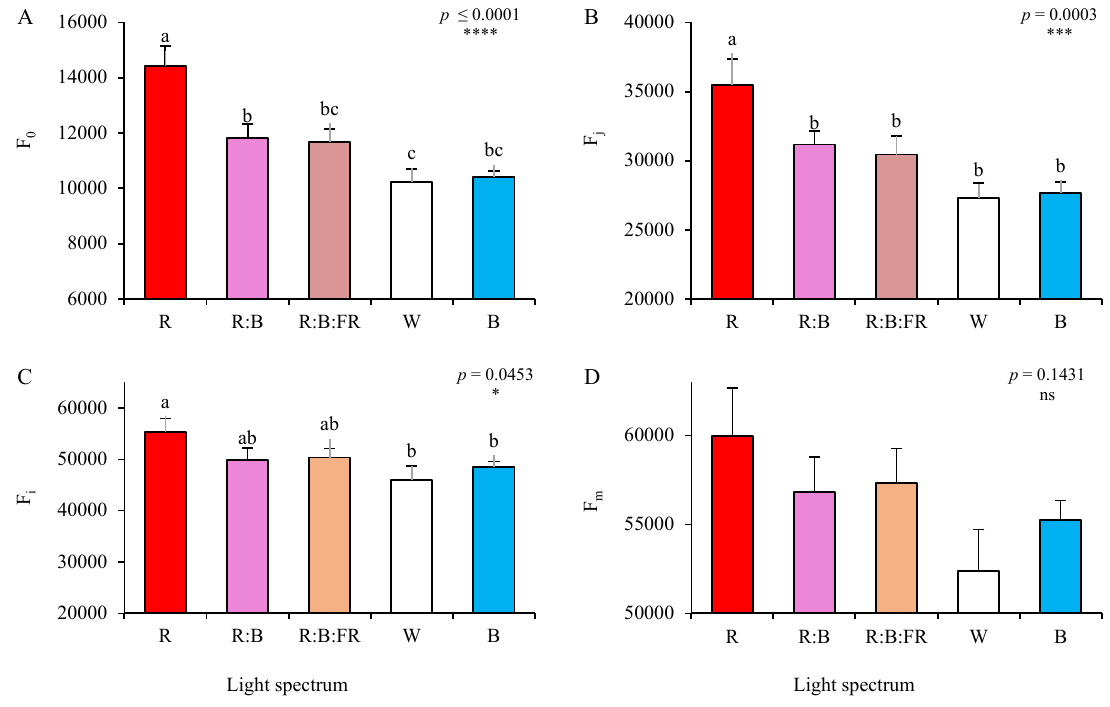
Figure 5. Minimum fluorescence (F 0 ; A ), fluorescence intensity after 2 ms (F j ; B ), fluorescence intensity after 30 ms of OJIP (F i ; C ), and maximum fluorescence (F m , D ) (equations and explanations in Table 2) of OJIP protocol applied to the leaves of chrysanthemum cuttings exposed for 30 days to different light quality regimes (red (R), red and blue (R:B), red, blue and far-red (R:B:FR), white (W) and blue (B); see the spectrum in Figure 9). During the experiment, the photosynthetic photon flux density was set to 150 ± 5 µmol m −2 s −1 . Six replicates per treatment were assessed. Columns with the same letters are not significantly different at p ≤ 0.05, according to Duncan's multiple range tests. Bars represent SEM.